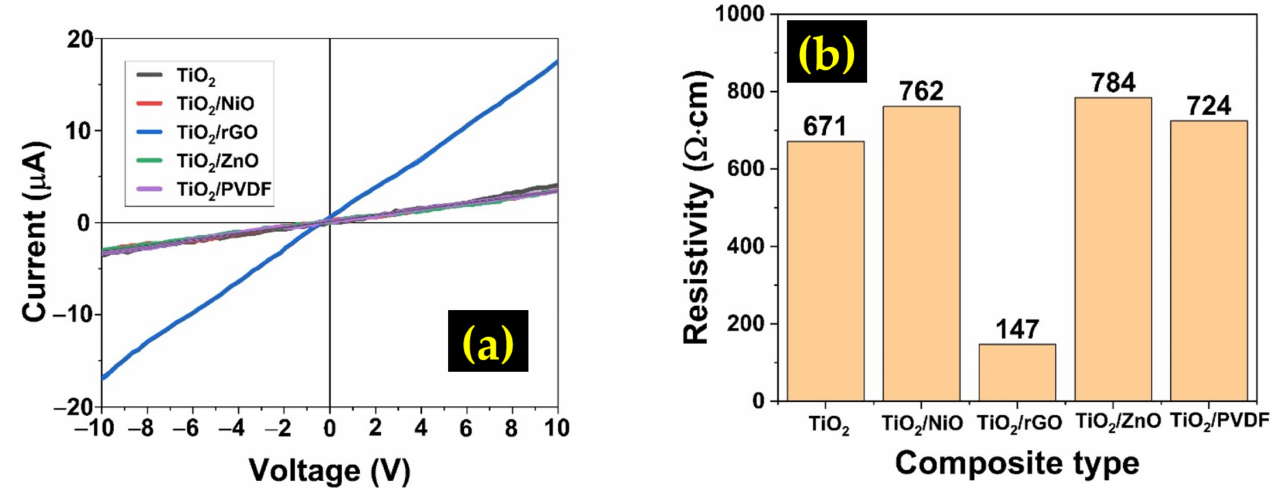
Figure 7. ( a ) I-V measurement result of different types of TiO 2 composites, ( b ) Comparison of the resistivity value of different types of TiO 2